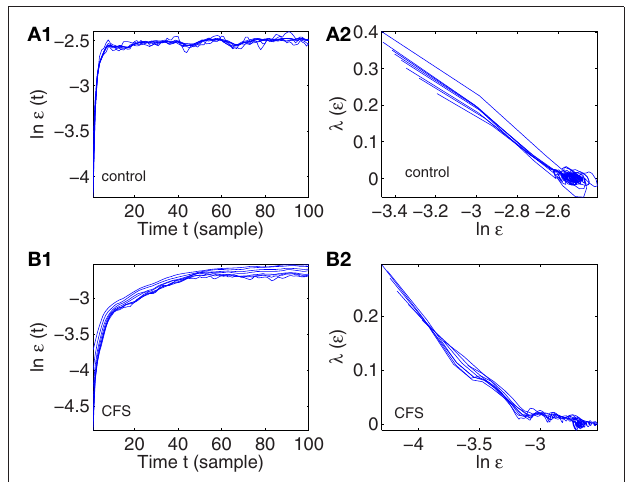
FIGURE 4 | Error growth ln ε ( t ) vs. t and SDLE λ( ε ) vs. ln ε curves for a control (A1, A2) and CFS (B1, B2) subject.